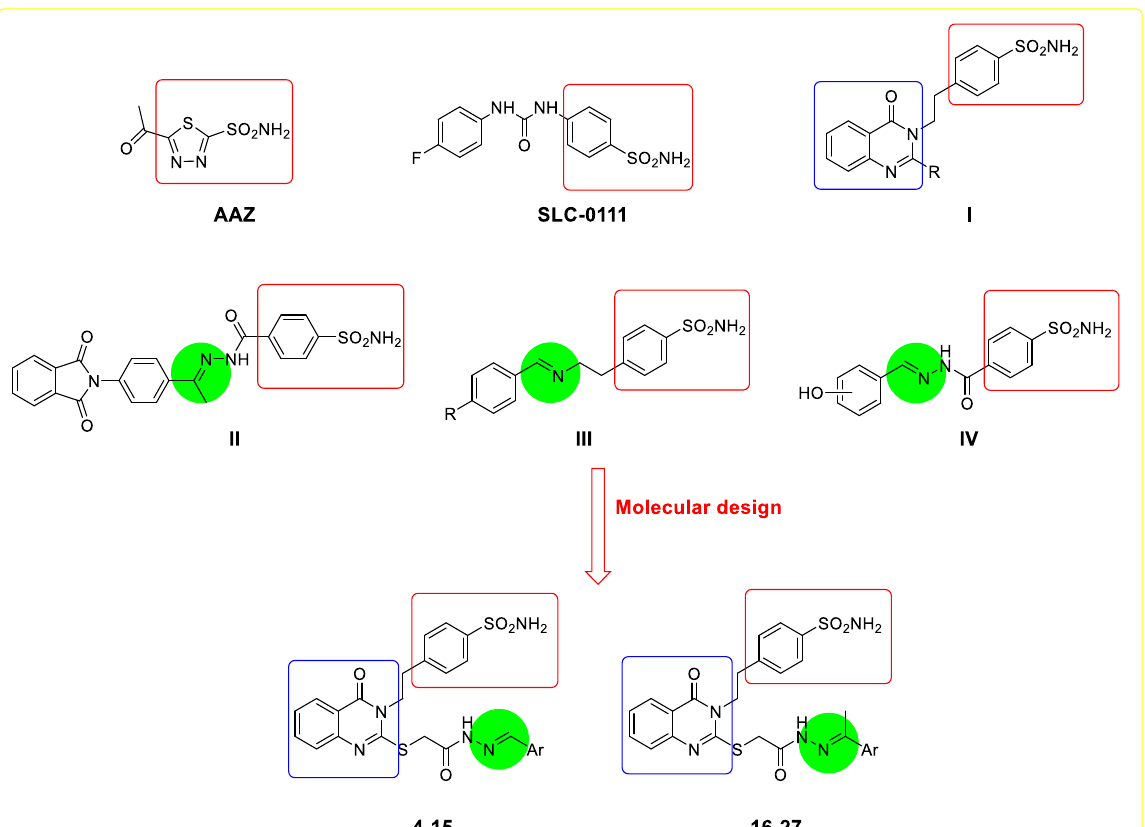
Figure 1. Structures of AAZ , SLC - 0111 , I - IV , and the designed Schiff’s bases incorporating quinazo- line scaffold ( 4 – 27 ) as carbonic anhydrase inhibitors (CAIs).